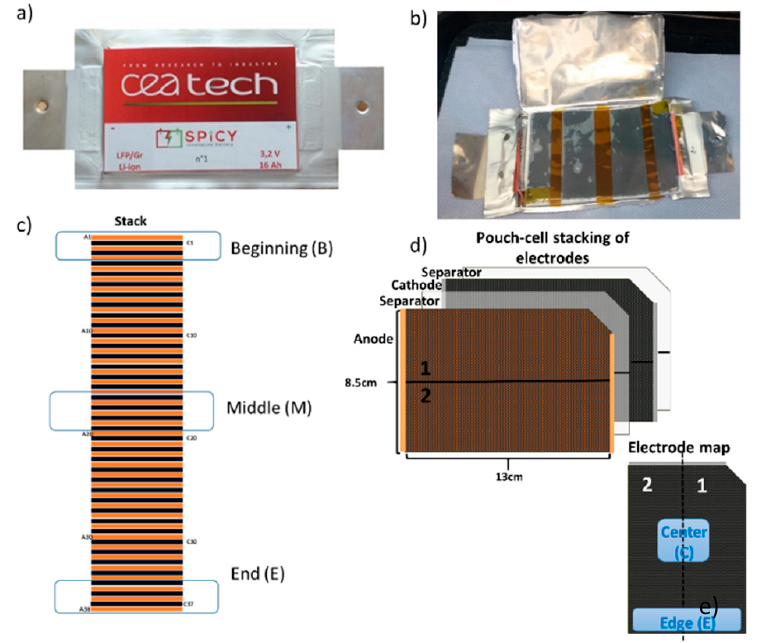
Figure 1. ( a ) Closed pouch cell; ( b ) view of the opened cell; ( c ) scheme of the stack defining the sampling portions; ( d ) simplified view of double coated electrode indicating the two areas sampled; and ( e ) definition of “edge” and “center” positions within a single electrode.